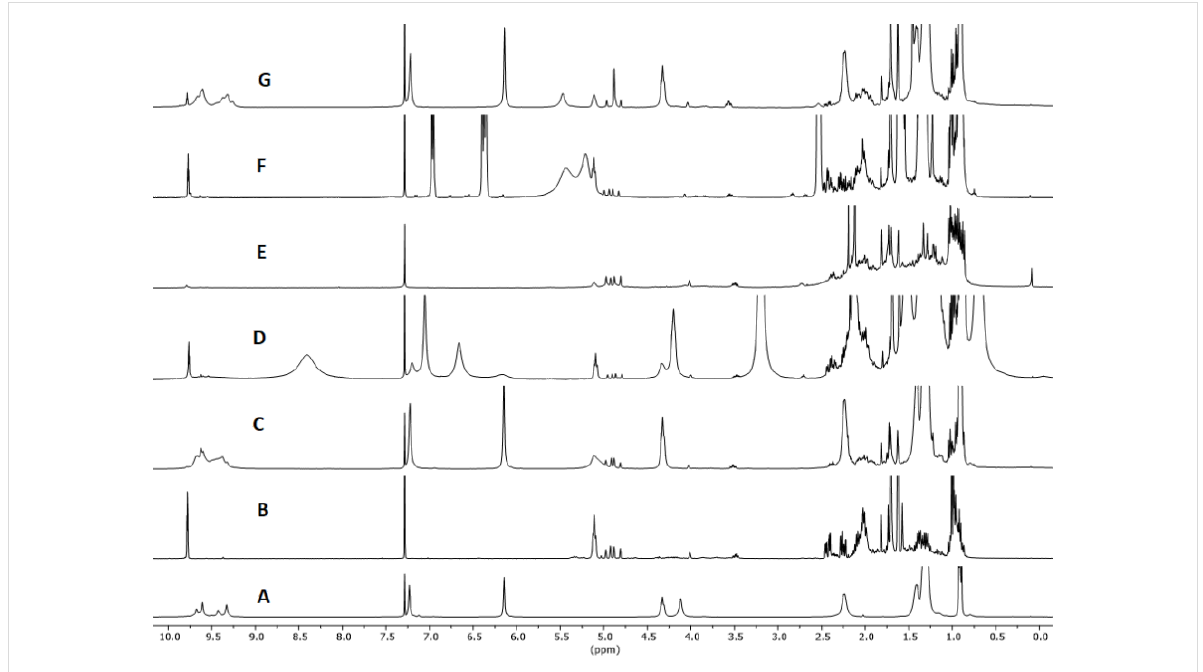
Figure 1: 1 H NMR spectra in water-saturated CDCl 3 except for G. A: [ 1 6 ] (7.5 mM); B: citronellal; C: citronellal (75 mM), [ 1 6 ] (7.5 mM); D: citronellal (75 mM), [ 1 6 ] (7.5 mM), Bu 4 NBr ( 3 , 78 mM); E: citronellal (75 mM), acetic acid (29 mM); F: citronellal (75 mM), n -hexylresorcinol ( 2 , 30 mM);